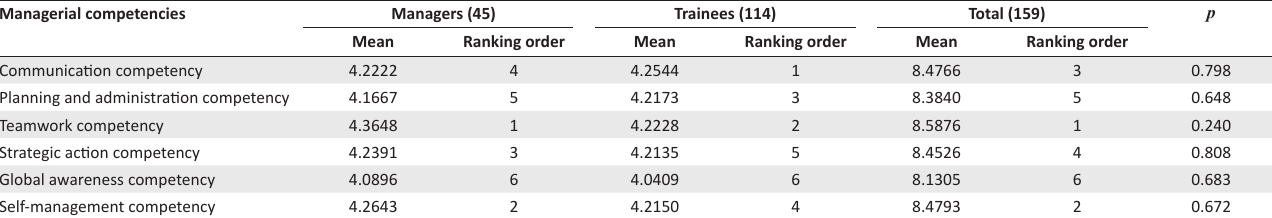
TABLE 10: Comparison of the six managerial competencies between managers and trainees using the Mann–Whitney